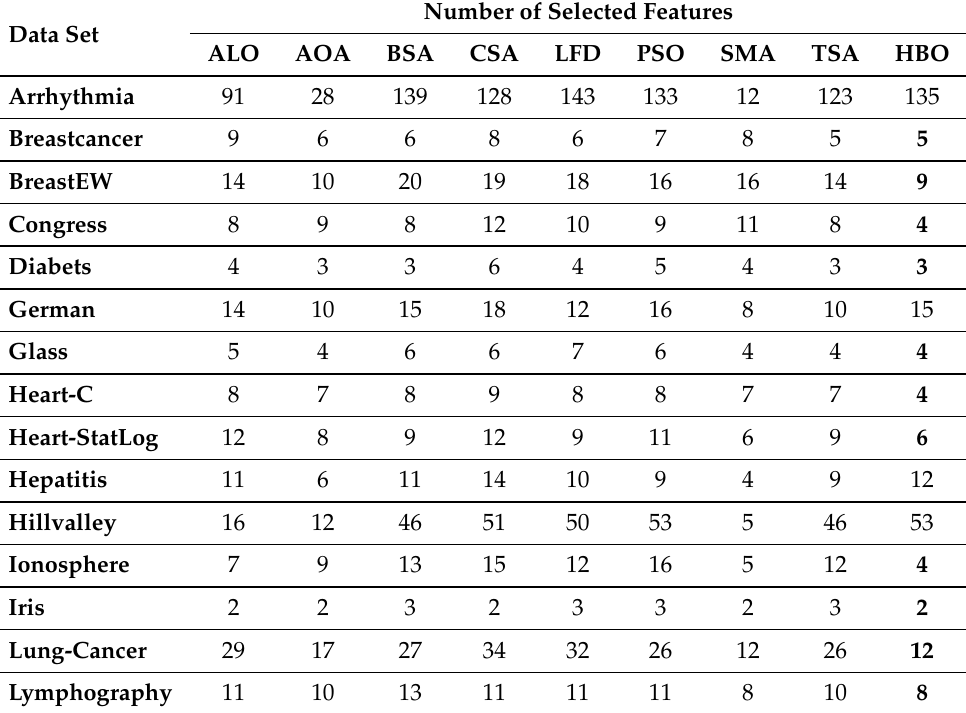
Table 9. The number of selected features of B_HBO against other recent